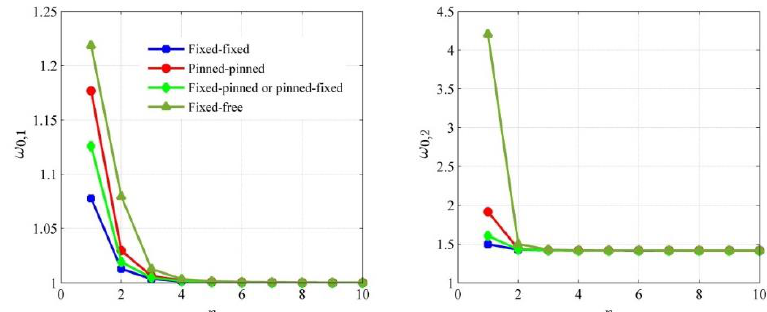
Figure 3. Frequency ratios in two sub-modes versus the order of basic mode for different boundary conditions when 𝑠 e = 100 , 𝑠 m = 1 and 𝑠 k = 2 .